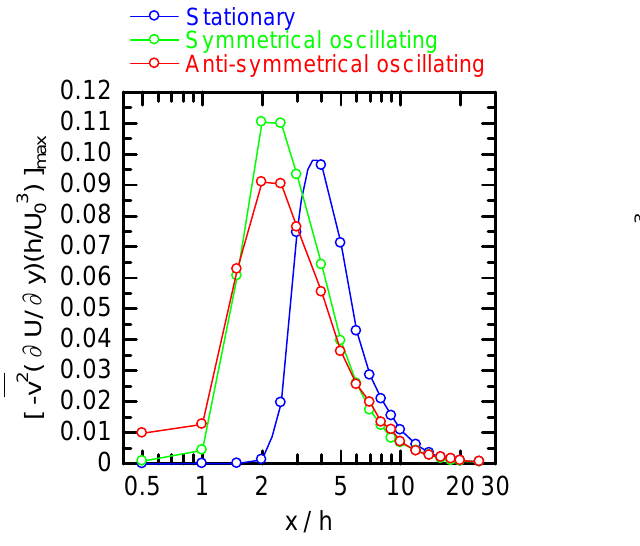
Fig. 15 Streamwise variation of maximum production Fig. 16 Streamwise variation of maximum